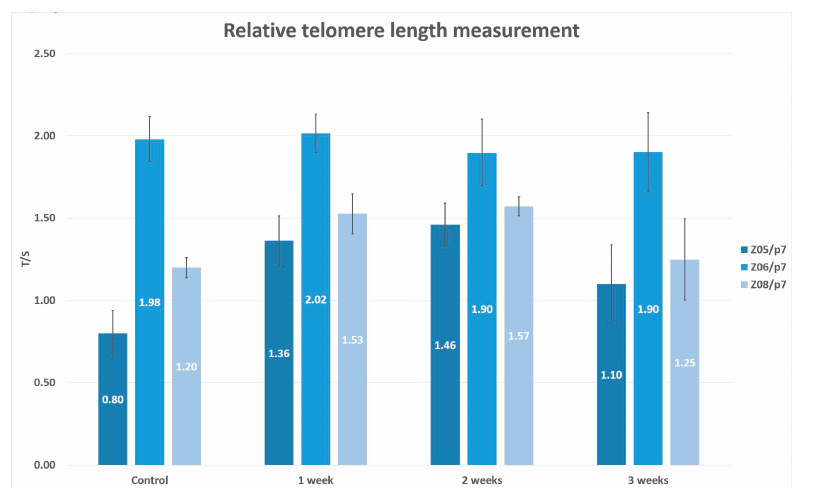
Figure 6. The relative telomere length measuremen—T/S ratio and standard deviations (lineages Z05/p7, Z06/p7, Z08/p7). The error bars were calculated for three technical replicates without biological